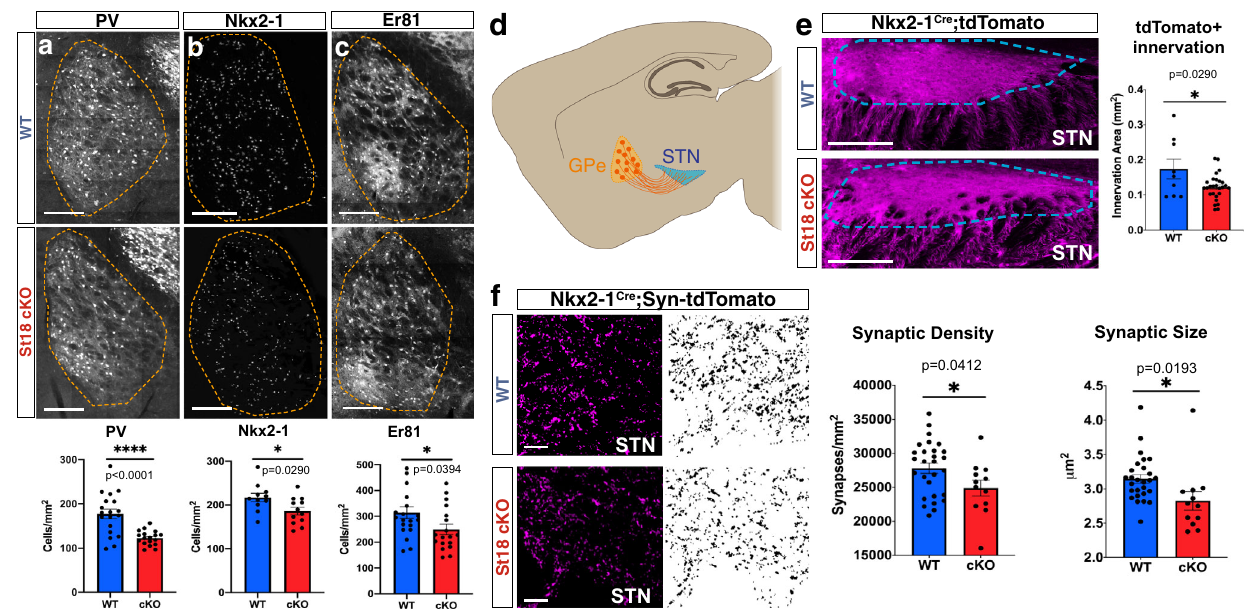
Fig. 5 | Conditional St18 KO produces a speci fi c loss of MGE lineage GPe pro- jectionneurons.a Quanti fi cationof PV+neurons (Unpaired t-test). N =19 WT and 18St18cKO. b Quanti fi cationofNkx2-1+neurons(Unpairedt-test). N =11WTand12 St18 cKO. c Quanti fi cationofEr81+neurons(Unpairedt-test). N =20WTand18 St18 cKO. d Schematic representation of adult mouse brain in the parasagittal plane showing axonal projections of GPe prototypic neurons (orange) targeting the STN (blue). e WT and St18 cKO STN (outlined in blue) with MGE lineage whole cell